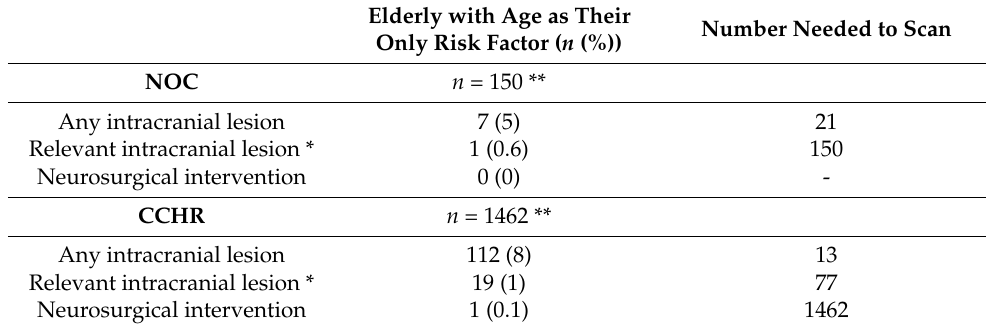
Table 4. Subgroup analysis of elderly patients with age as their only risk factor after